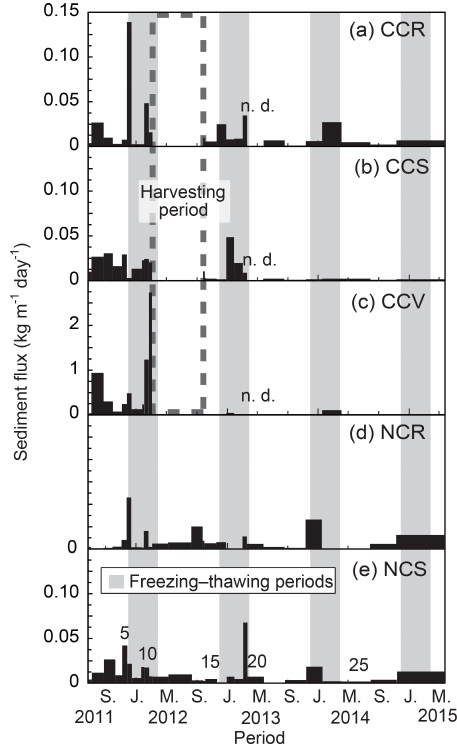
Figure 11. Temporal changes in the sediment flux: (a) plots CCR, (b) CCS, (c) CCV, (d) NCR, and (e) NCS. Numbers in (e) indicate sampling periods listed in Table